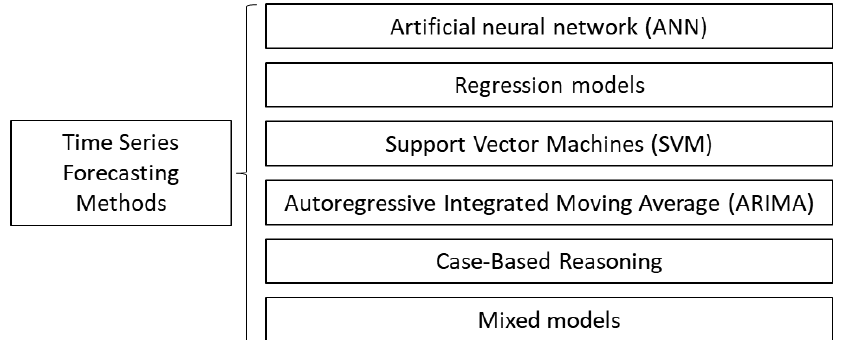
Figure 2. The methodology for prediction time